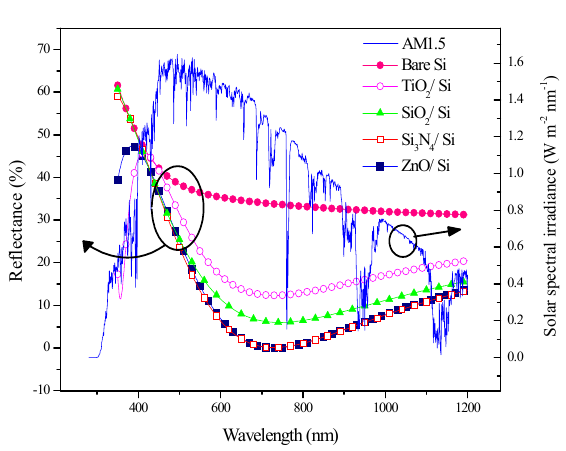
Fig. 2 . Reflectance as a function of wavelength for the structures of Si, TiO 2 /Si, SiO 2 /Si, Si 3 N 4 /Si, ZnO/Si and also the spectral irradiance of the AM1.5